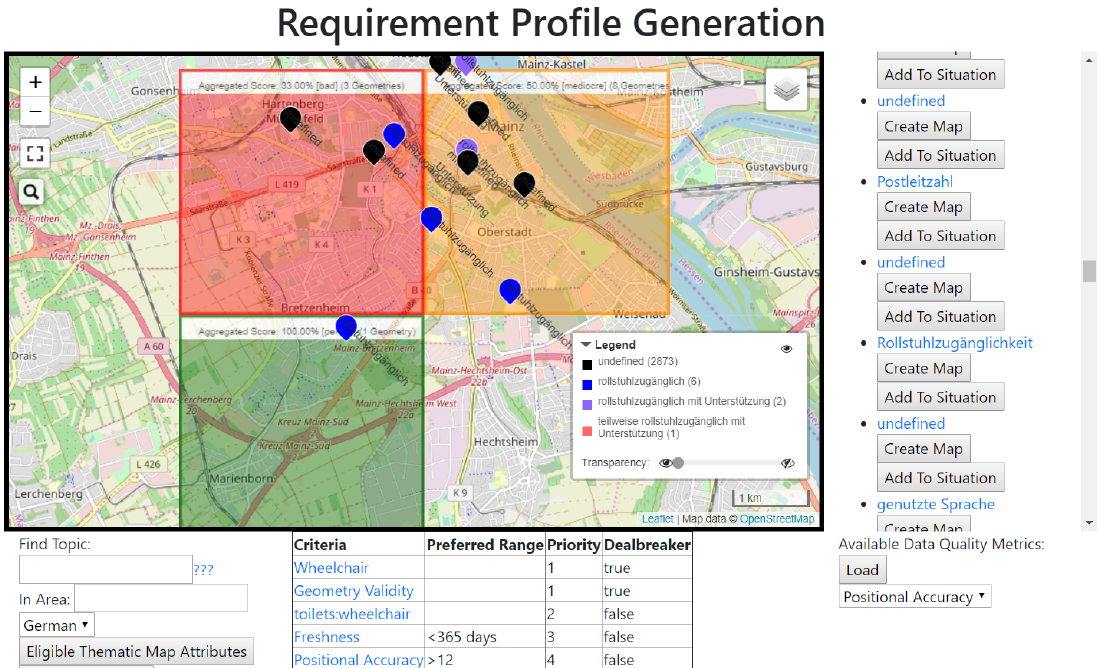
Figure 4. Requirement Profile Suggestion: A requirement profile is suggested by the system for the usecase of School Wheelchair Accessibility according to the workflow described